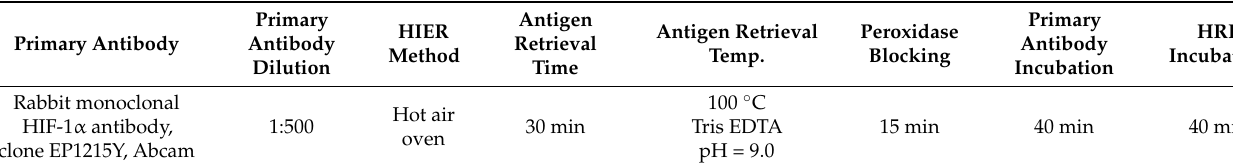
Table 1. Immunohistochemistry-staining protocol.